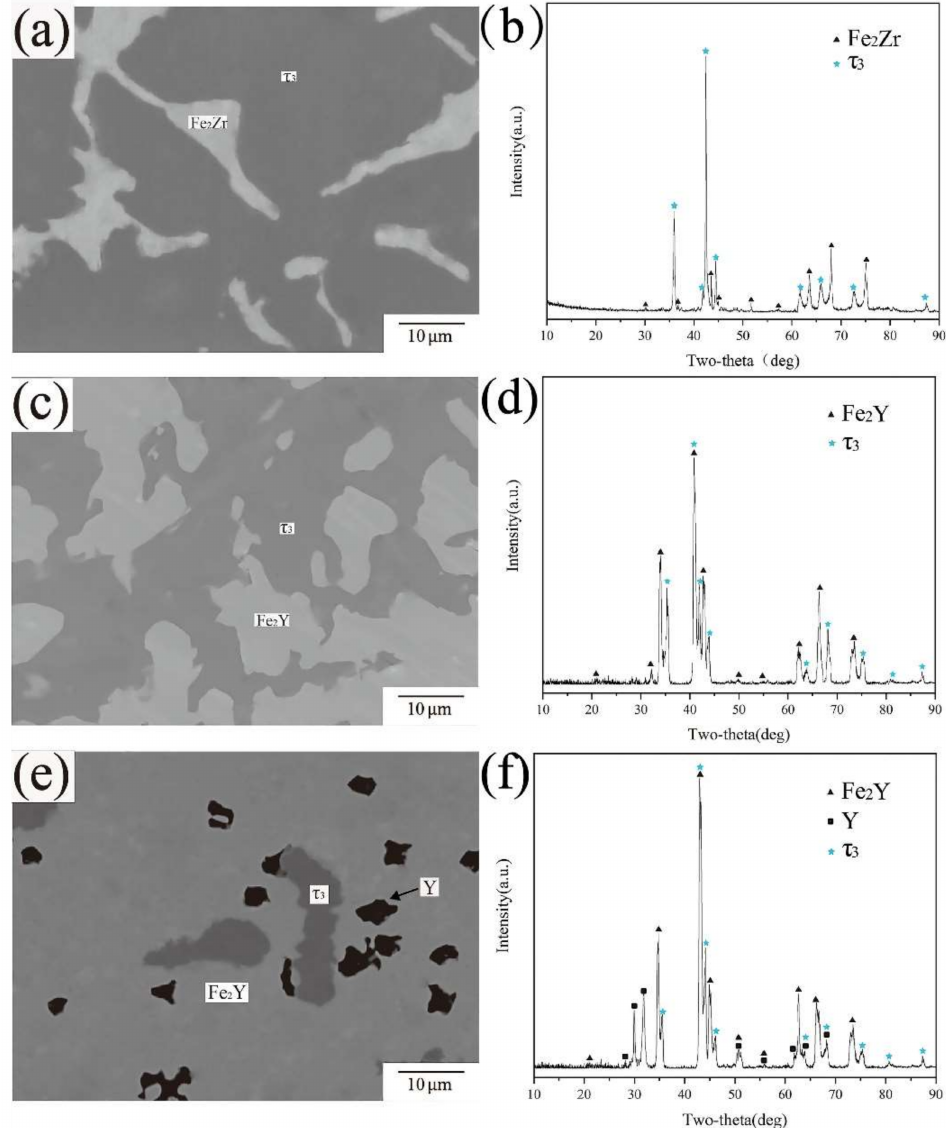
Figure 7. ( a ) BSE image of A13 ( b ) XRD pattern of A13 ( c ) BSE image of A1 of A24 ( d ) XRD pattern of A24 ( e ) BSE image of A7 ( f ) XRD pattern of